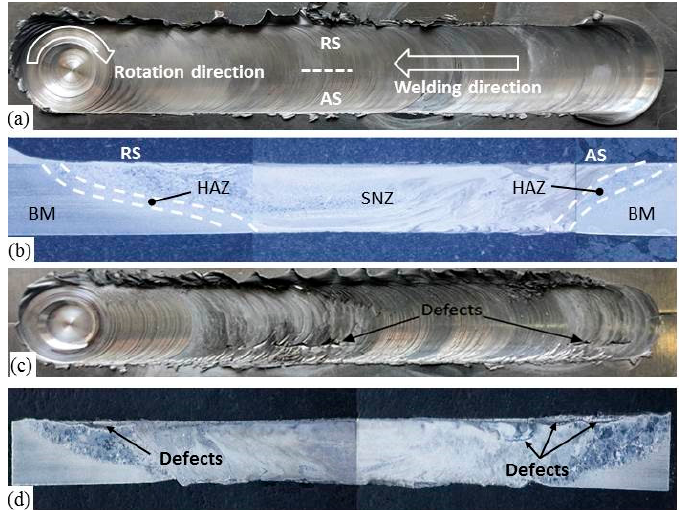
Figure 8. Joint surface morphology ( a ) at 1100 rpm, 20 mm/min; ( c ) at 700 rpm, 20 mm/min; Macroscopic view of joints cross-section ( b ) at 1100 rpm, 20 mm/min; ( d ) at 700 rpm, 20 mm/min.